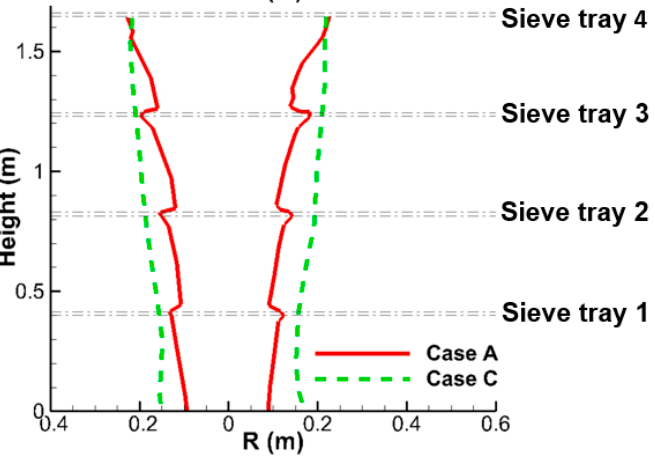
Figure 14. This schematic shows the radius of liquid column of the small-scale tower for Cases A and